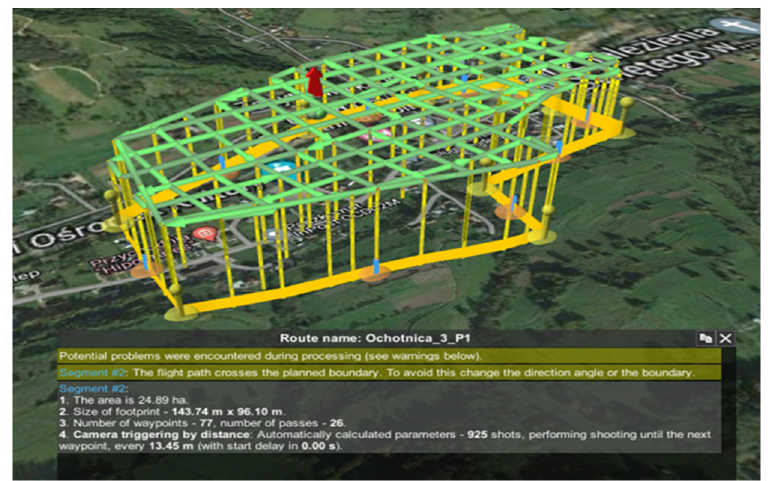
Figure 3. Flight project with basic parameters for the DJI Zenmuse P1 sensor—UgCS software.